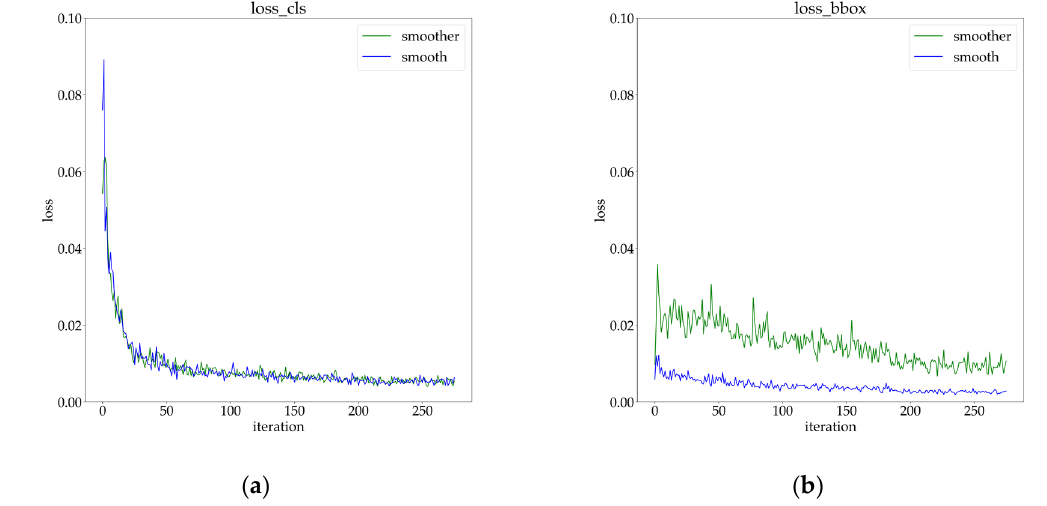
Figure 9. The visualization of training with the smoother L1 ( α = 2, β = 2) and the smooth L1: ( a ) classification loss; ( b ) localization loss in bounding box regression.